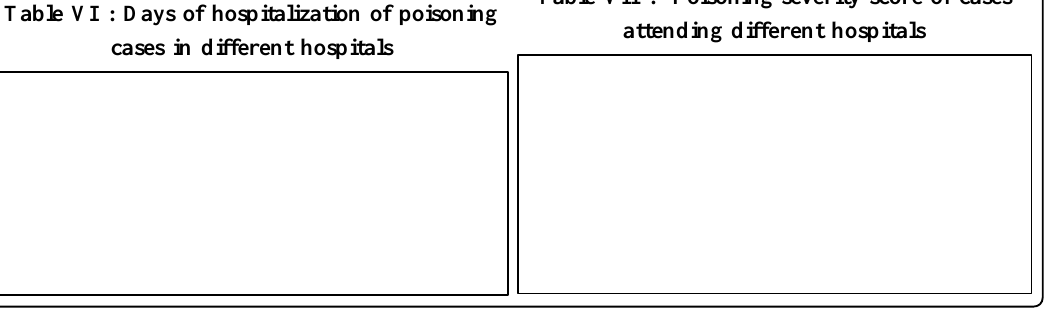
Table VI : Days of hospitalization of poisoning